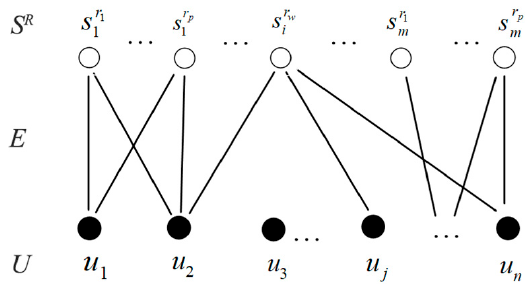
Figure 2. Undirected bipartite graph G R .